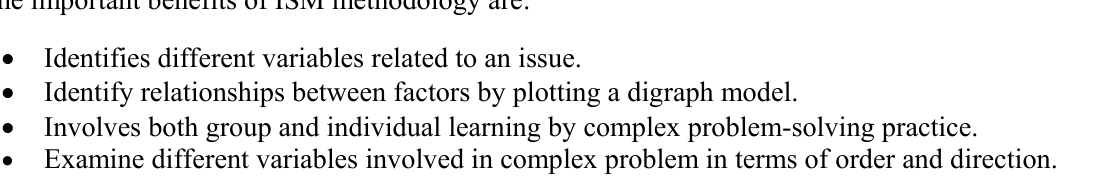
Recent applications of ISM approach Authors (years) Focus area of combined ISM and MICMAC approach Complexity of system maintainability analysis Vasanthakumar et al.(2016) Analysis of factors influencing lean remanufacturing practices Purohit et al .(2016) Framework for mass customization enablers Dwivedi et al .(2016) Driving innovation through big open linked data (BOLD) Shen et al .(2016) Implementation of Emission Trading System in the Chinese building sector Trivedi et al .(2015) Analysis of key factors for waste management in humanitarian response Luthra et al .(2015) Analysis of interactions among critical success factors to implement green supply chain management towards sustainability Analysis on supply chain risks in Indian apparel retail chains and proposal of risk prioritization model Garg et al